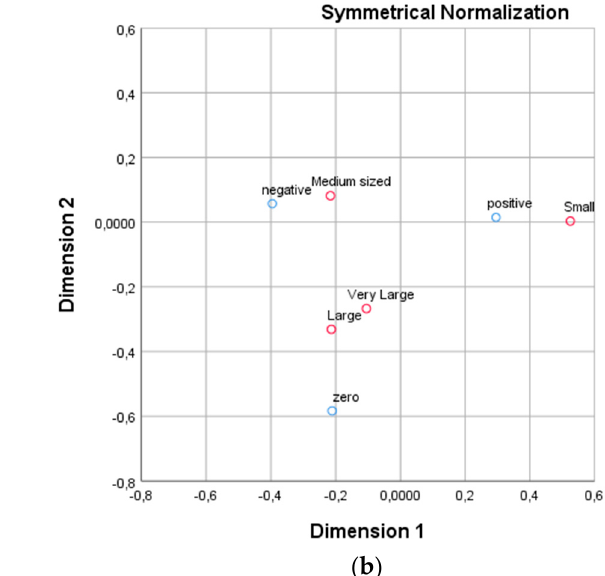
Figure 1. Correspondence map: ( a ) 2017/2018; ( b ) 2018/2019.